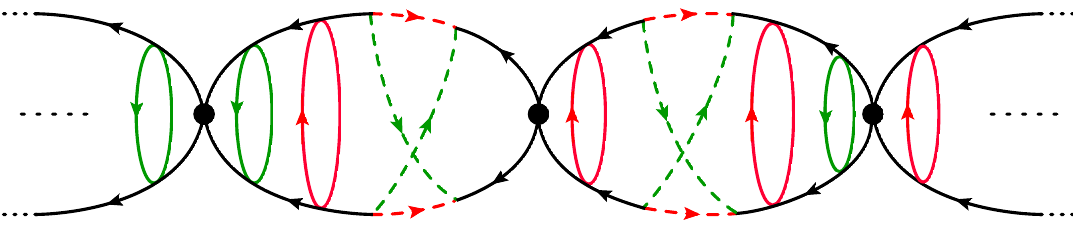
. The black (cid:30) 1 (cid:30) 1